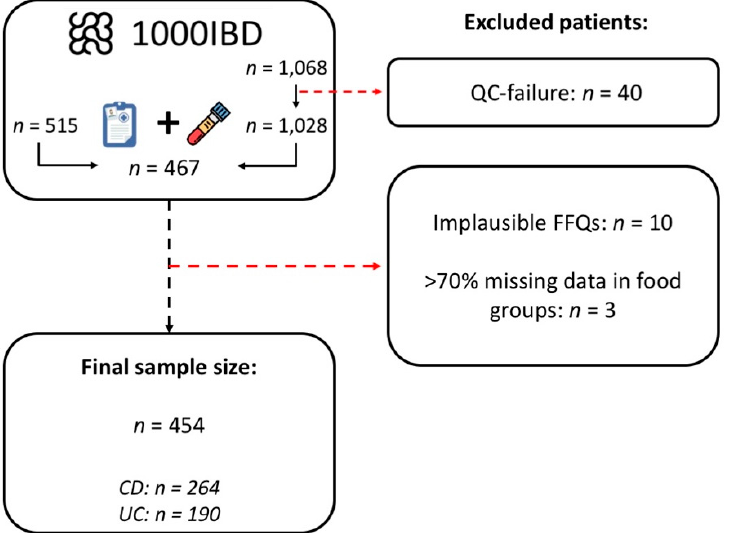
Figure 1. Flowchart of the study inclusion and exclusion of participants. In total, proteomics data were generated for 1028 patients who participated in the 1000IBD project, while for 515 patients FFQs were available. After cross-referencing both datasets, overlapping data were available for 467 patients. After excluding FFQs with implausible energy intake or missing food items, a final total of 454 patients were eligible for analysis in the present study. Abbreviations: CD, Crohn’s disease; FFQ, food frequency questionnaire; QC, quality control; UC, ulcerative colitis.